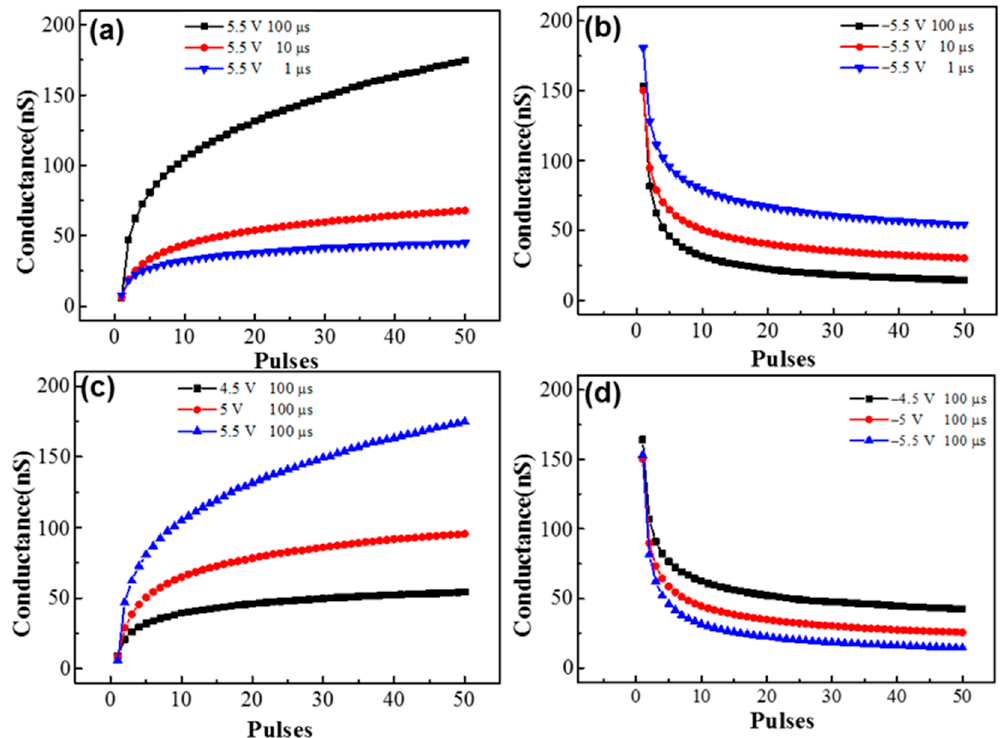
Figure 4. The measured long-term potentiation and long-term depression synaptic function with identical pulses. A total of 50 pulses with 5.5 V pulse amplitude and different pulse widths for ( a ) potentiation (1 µ s, 10 µ s, and 100 µ s); ( b ) depression (1 µ s, 10 µ s, and 100 µ s); 50 pulses with 100 µ s pulse width and a different pulse amplitude ( c ) for potentiation (4.5 V, 5 V, and 5.5 V) and ( d ) for depression ( − 4.5 V, − 5 V, and − 5.5 V).